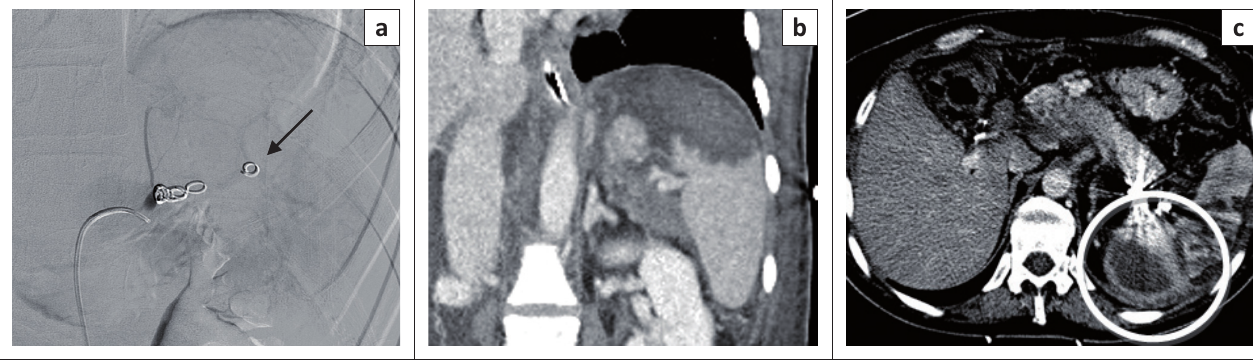
FIGURE 5: Complications included coil migration, splenic infarction and splenic abscess: (a) Fluoroscopic image shows distal migration of main splenic artery embolisation coil (arrow), (b) contrast-enhanced coronal CT shows non-enhancement of the superior pole of the spleen consistent with splenic infarct and (c) contrast-enhanced axial CT shows rim enhancing splenic abscess (circle).